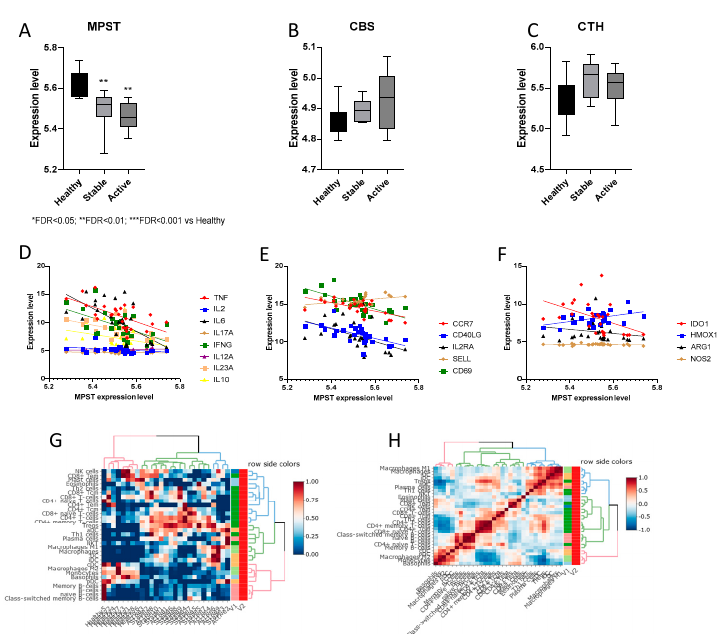
Figure 6. Expression of the H2S-producing enzymes in th ePBMCs from multiple sclerosis (MS) patients. The expression levels of Mercaptopyruvate Sulfurtransferase (MPST) ( A ), Cystathionine Beta-Synthase (CBS) ( B ), and Cystathionine Gamma-Lyase (CTH) ( C ) were evaluated in the PBMCs from healthy donors and drug-naïve relapse-remitting MS patients, by interrogating the publicly available GSE138064 dataset, retrieved from the GEO database (https://www.ncbi.nlm.nih.gov/gds [48]). Data are shown in log2 scale. ( D ) Correlation between the MPST expression and the cytokines,